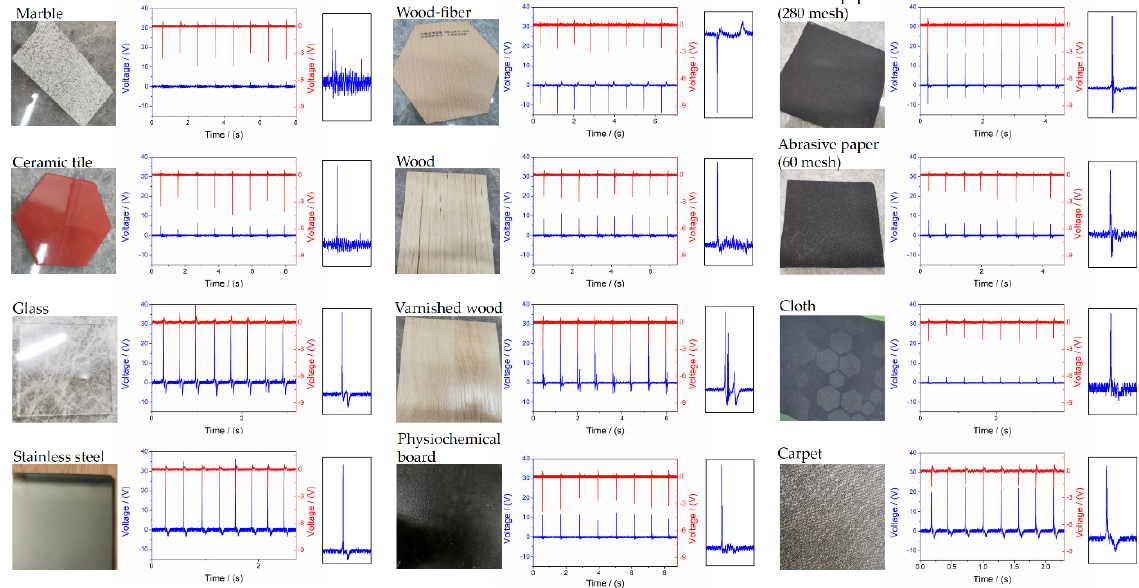
Figure 7. Analysis of specific response behavior to texture recognition. The double signal is generated from hitting different textures under vertical force.